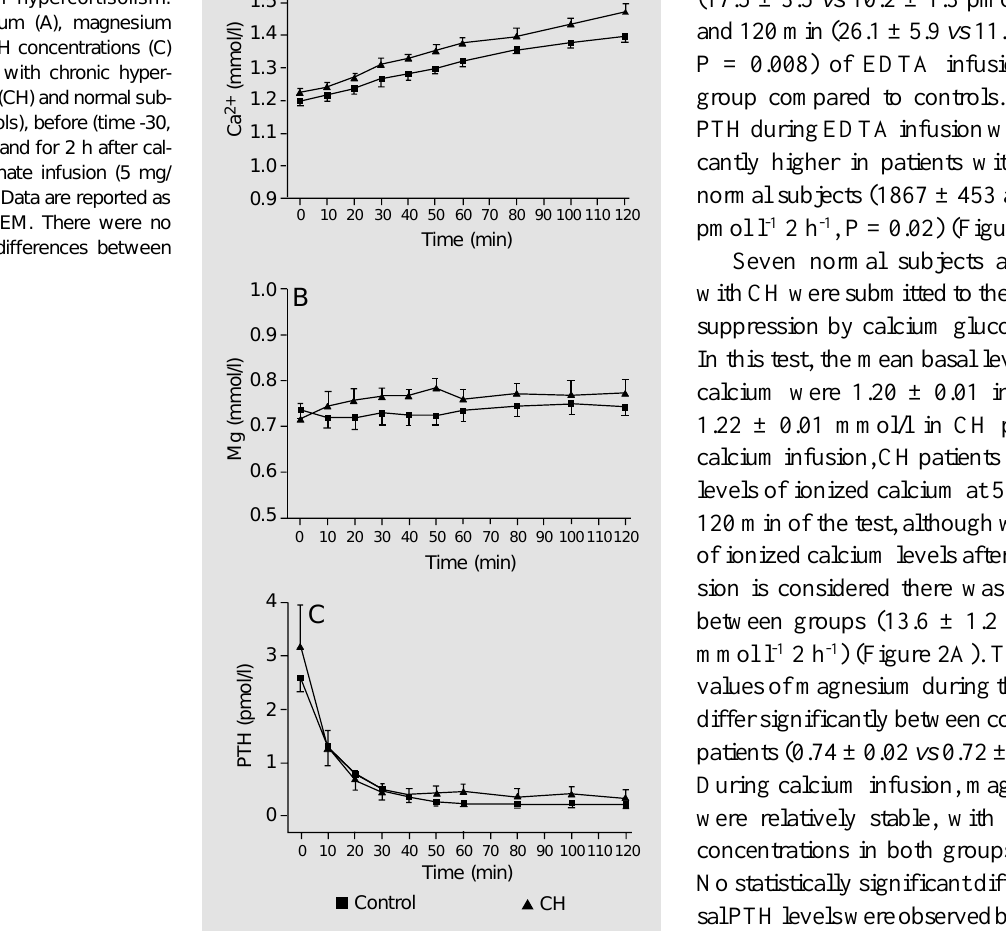
Figure 2. Intravenous test of parathyroid hormone (PTH) sup- pression in